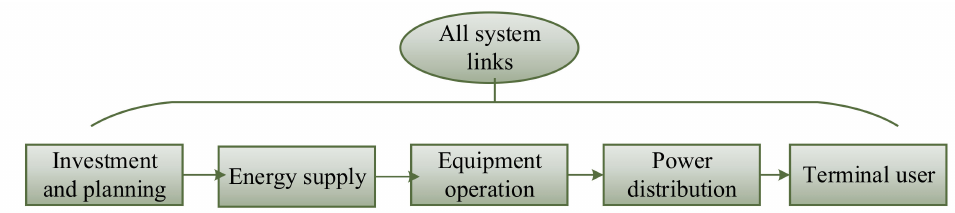
Figure 1. The whole chains of the integrated electricity–gas energy system